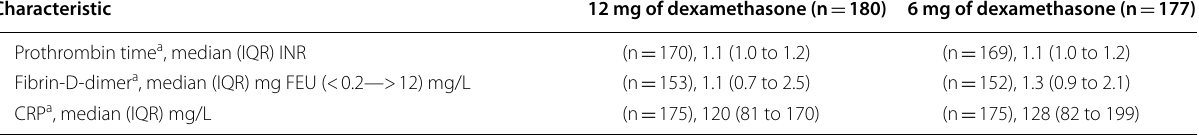
Table 2 Primary and secondary outcomes by dose of dexamethasone